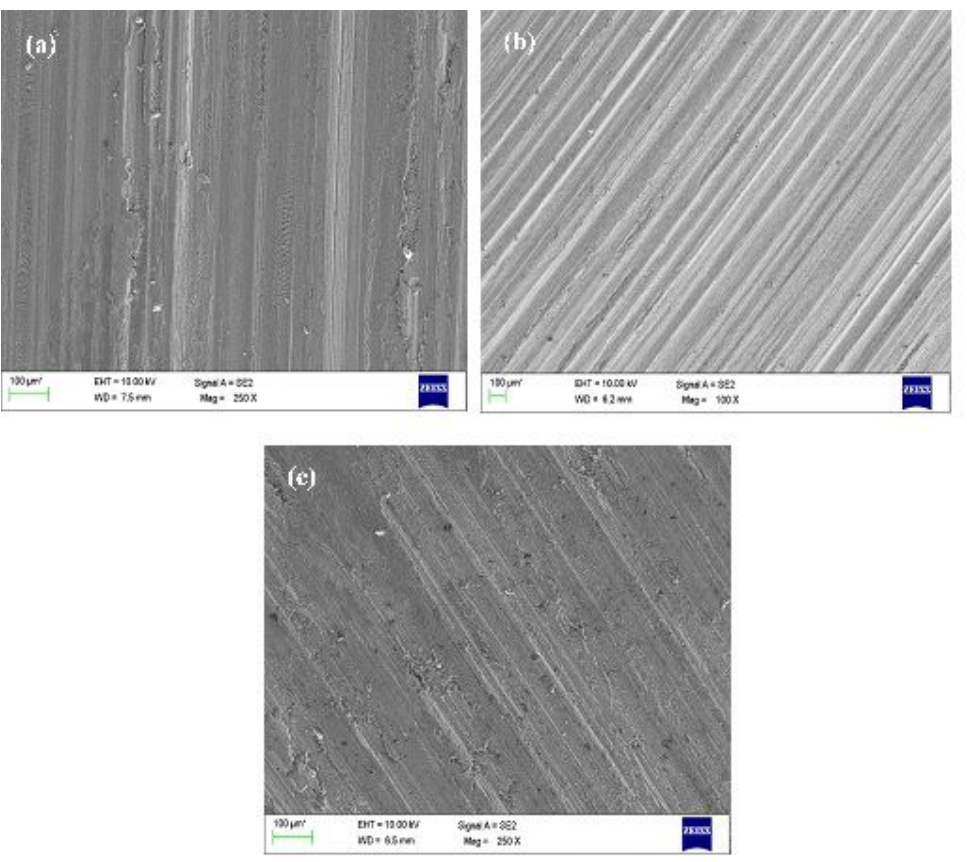
Figure 7: Typical wear surface at applied load of 39.2 N and sliding speed of 4.59 m/s and sliding distance of 1500 m (a) base alloy; (b) mono composite; (c) hybrid